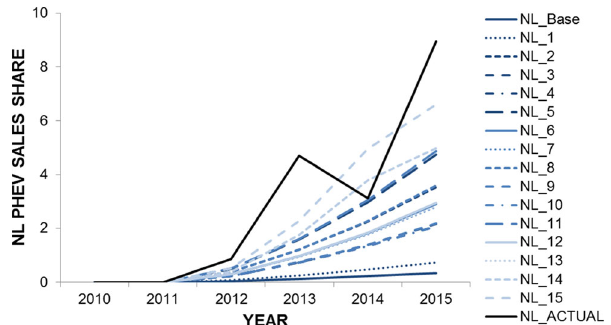
Fig. 3 NL PHEV sales shares under scenario conditions detailed in Table 3 and actual sales detailed in Table